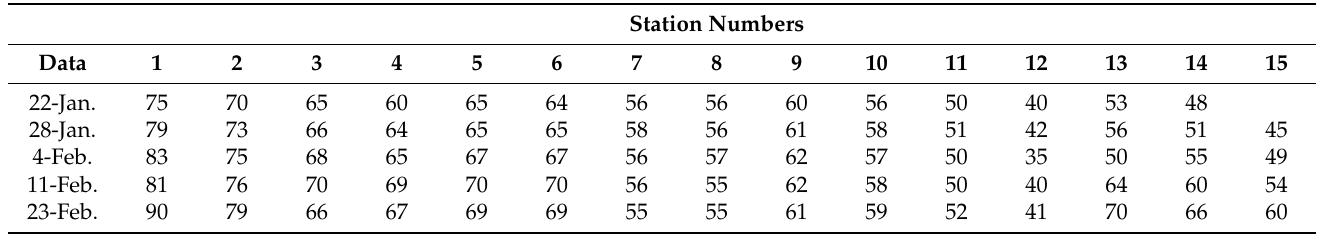
Table 1. Ice thickness (cm).